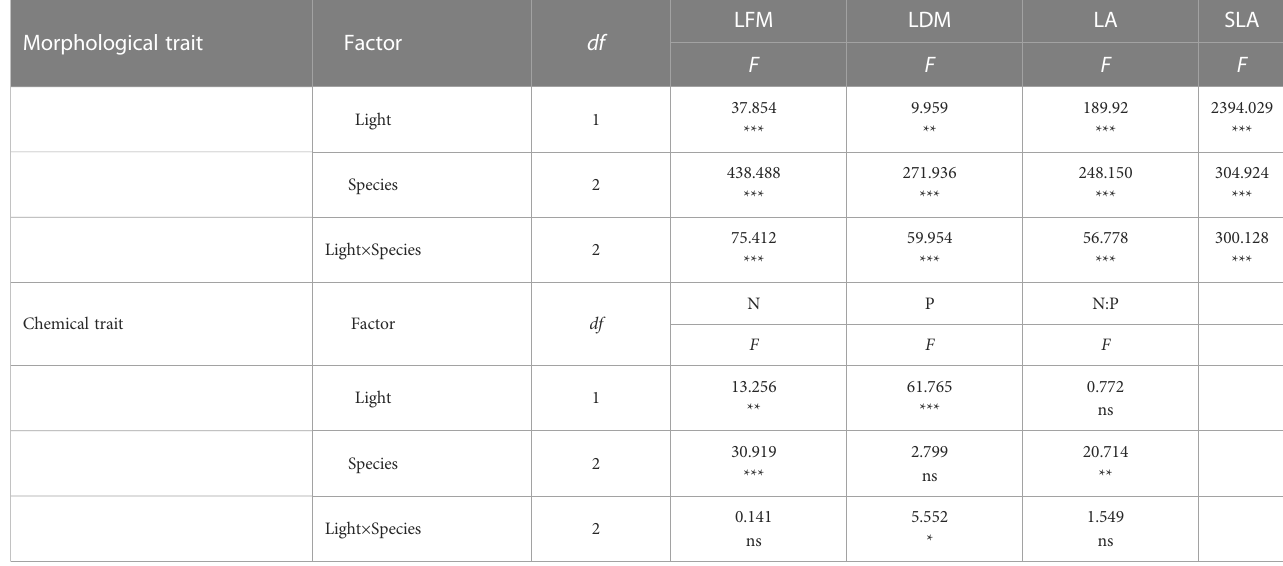
TABLE 4 Results of two-ways ANOVA for the effects of light conditions, species and their interactions on functional traits of urban plants.